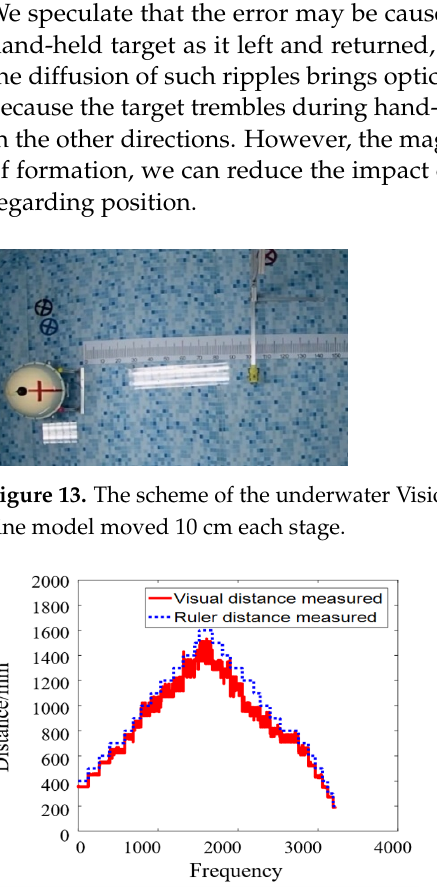
Figure 14. The distance on the Z-axis measured by the binocular camera compared with the